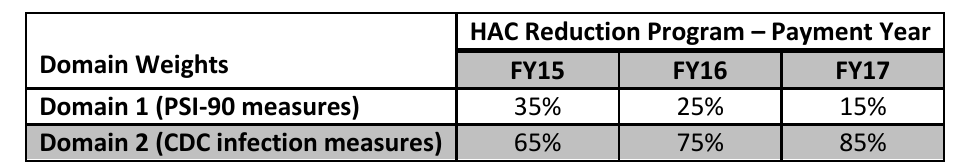
Table 6.1. HAC Reduction Program Domain Weights, by